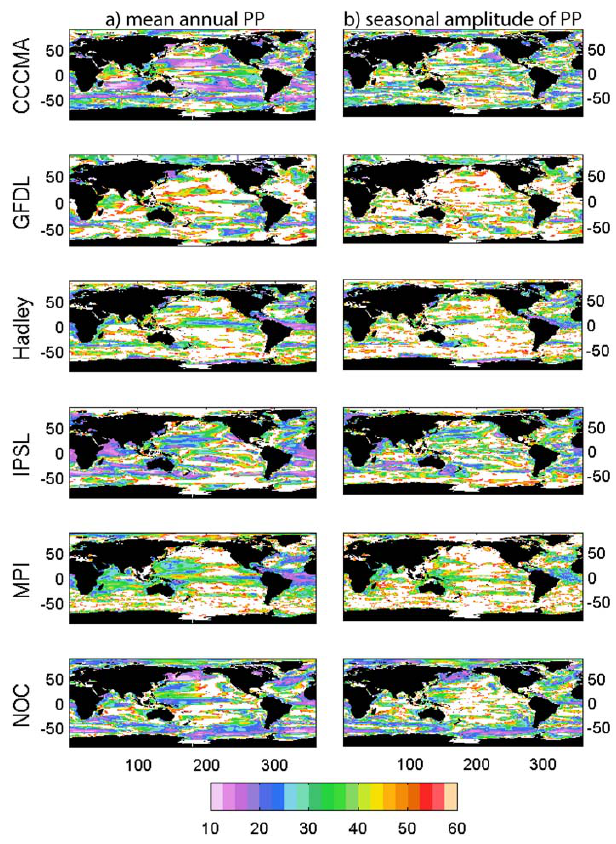
Figure 7: Number of years of continuous data required to separate a global warming Fig. 7. Number of years of continuous data required to separate a global warming trend (RCP8.5 scenario, 2006–2100) from natural trend (RCP8.5 scenario, 2006-2100) from natural variability in time series of a) mean variability in time series of (a) mean annual primary production and annual primary production and b) seasonal amplitude of primary production. Only (b) seasonal amplitude of primary production. Only points where points where the trend is statistically significant at the 95% level are plotted. the trend is statistically significant at the 95% level are